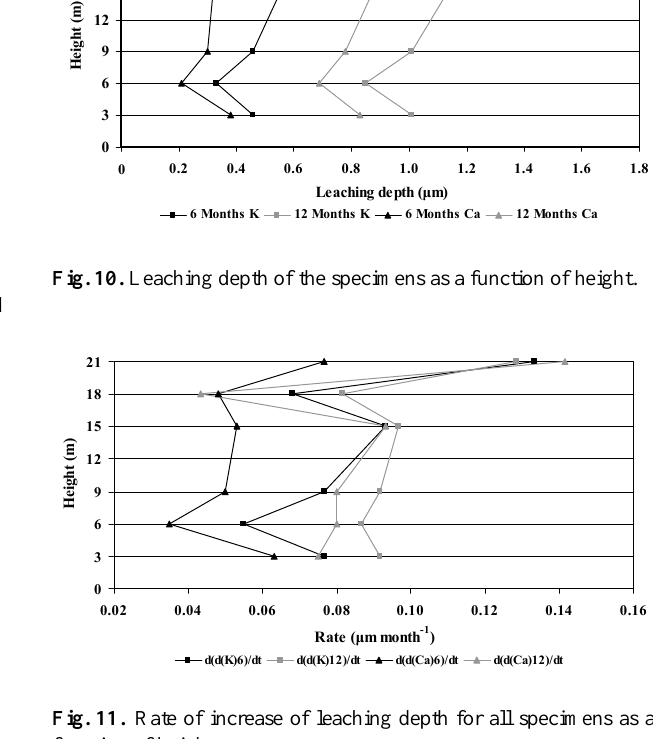
Fig. 11. Rate of increase of leaching depth for all specimens as a function of